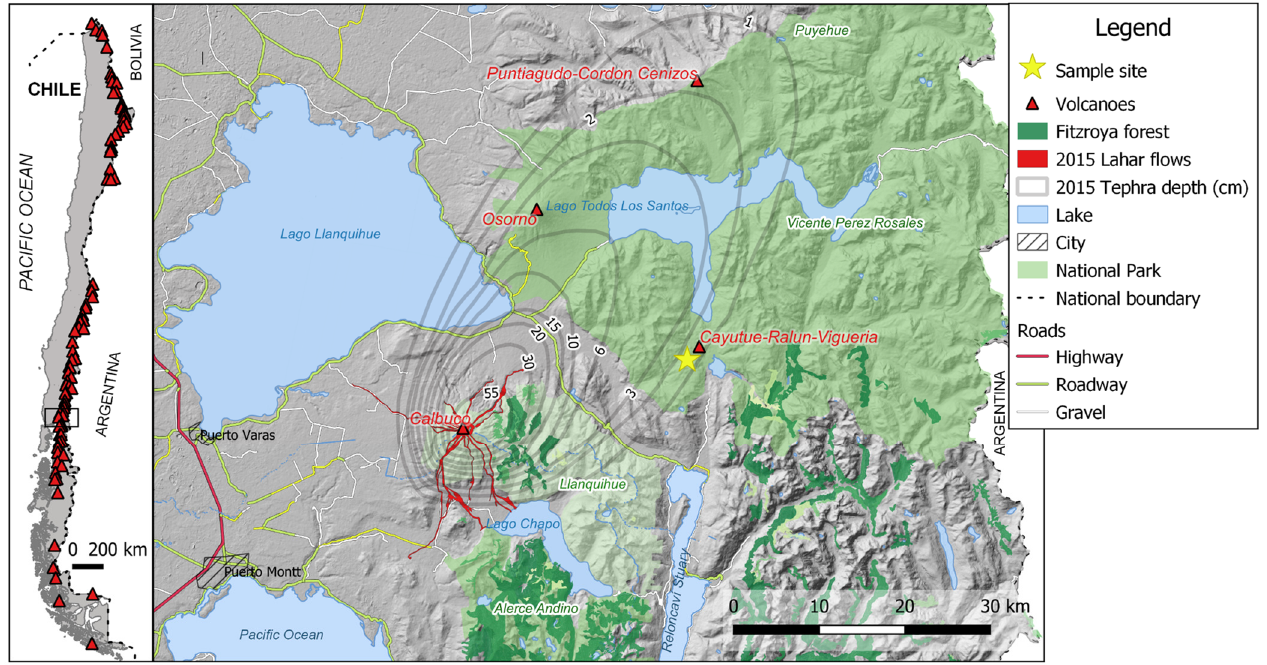
Figure 1. Map of study area indicating Calbuco volcano and the F. cuppressoides sampling site. The lahar flows and tephra deposition (cm depth) during the Calbuco eruption of 2015 [54] are indicated with red lines and isopachs, respectively. On the left is a map of Chile indicating the location of active volcanoes in red triangles.